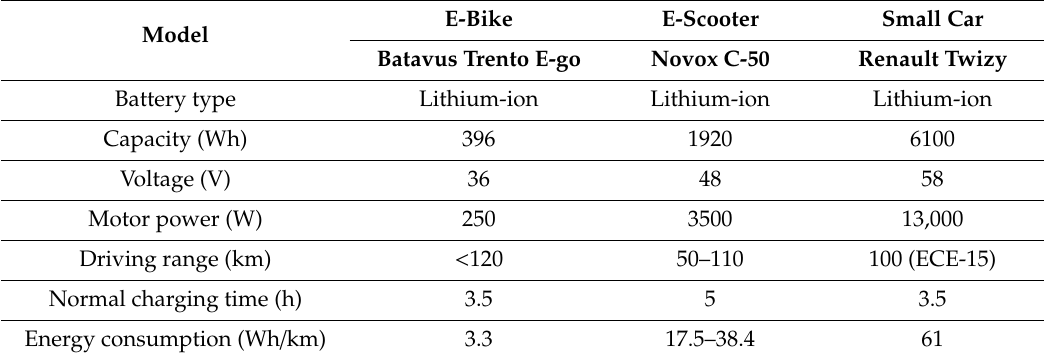
Table 2. Specifications of the E-bike and